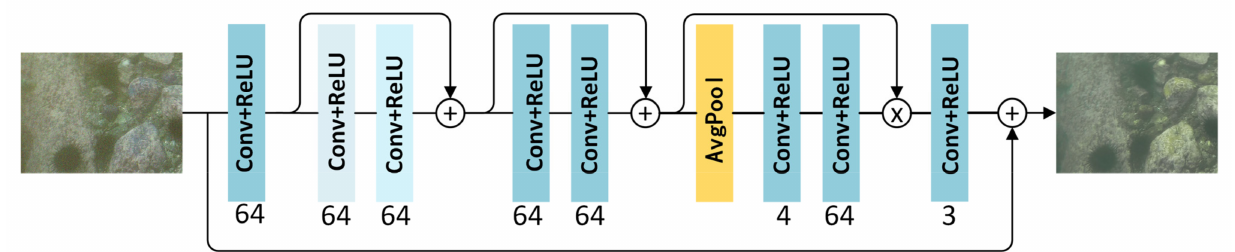
Figure 2. The diagram of the blind denoising sub-module